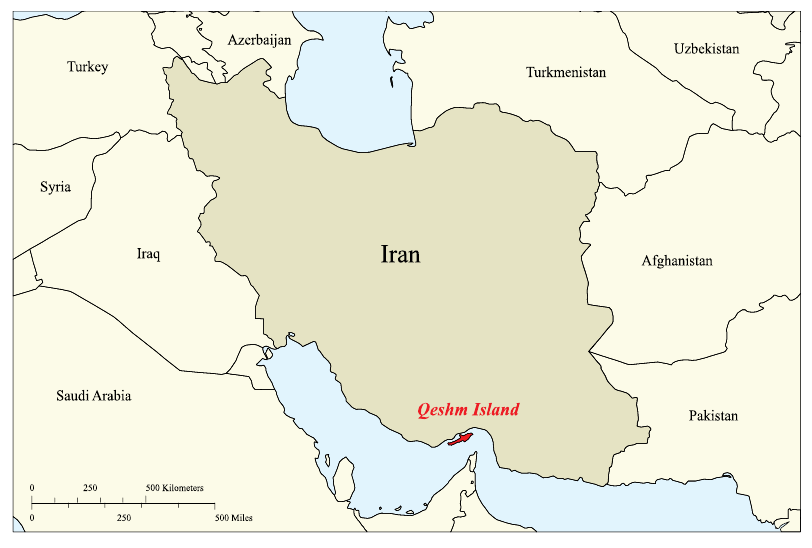
Figure 1. Location of Qeshm Island in